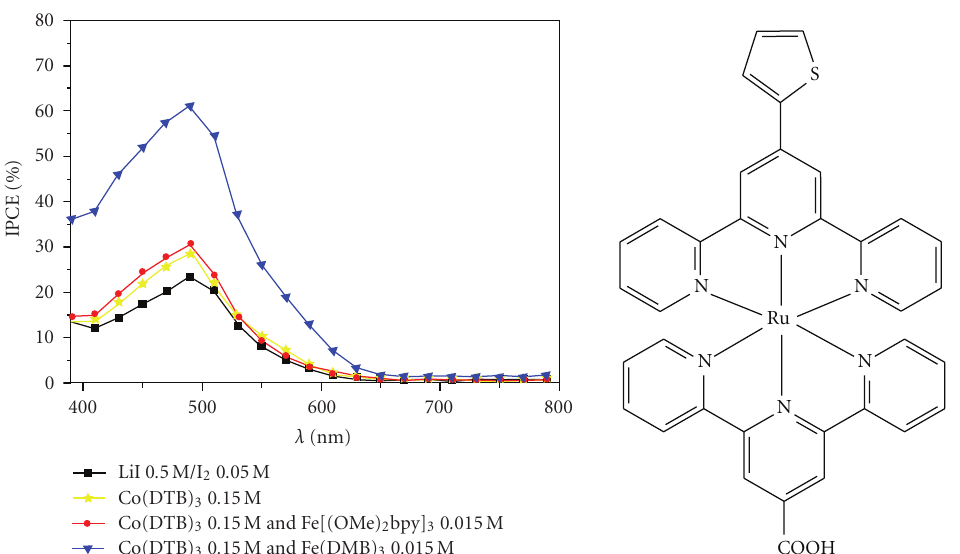
Figure 16: IPCE spectra in the presence of various electron mediators obtained by using the [Ru(II)(terpy)(Thpterpy)] 2+ dye as a TiO 2 photosensitizer. Thpterpy stands for the 4 (cid:3) -thiophene terpyridine.